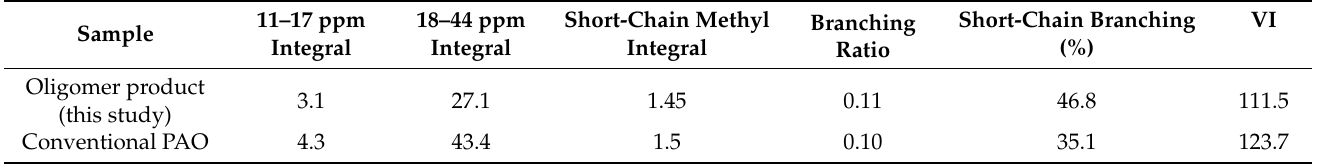
Table 1. Branching properties from C 13 -NMR analysis and viscosity index (VI) of the liquid product obtained from the experiment at a reaction temperature of 483 ◦ C and a reaction time of 150 min, compared to the conventional